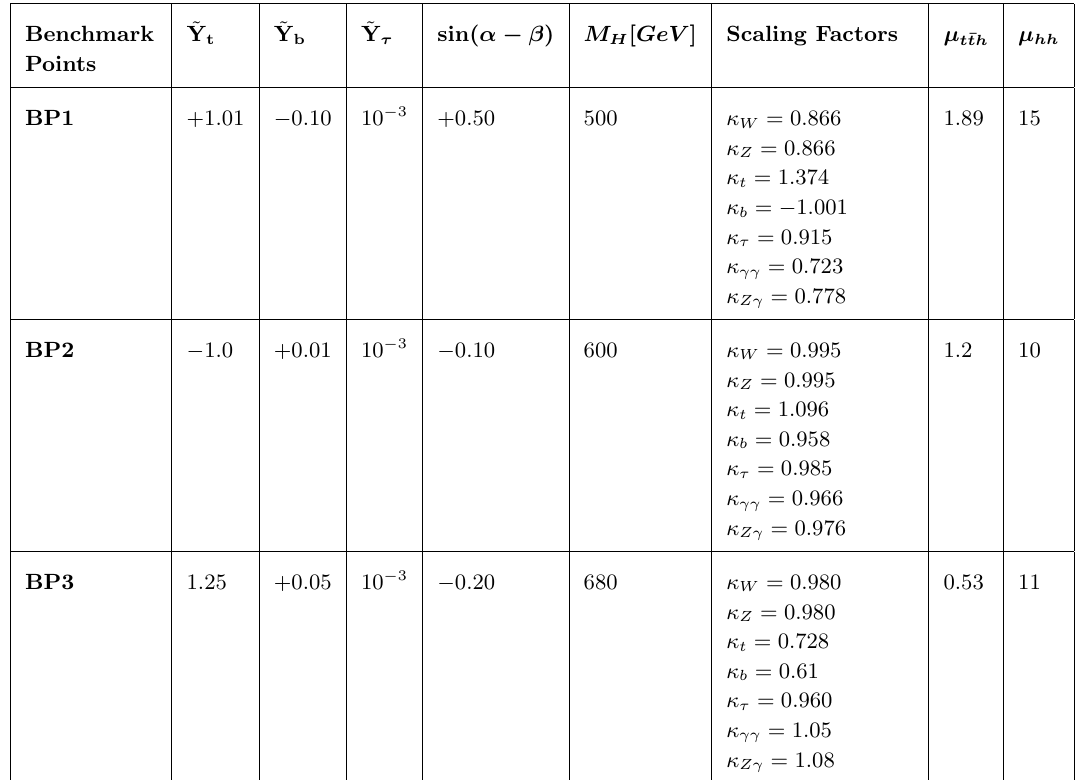
Table 5 . Sample points on parameter space and corresponding (cid:22) hh and (cid:22)